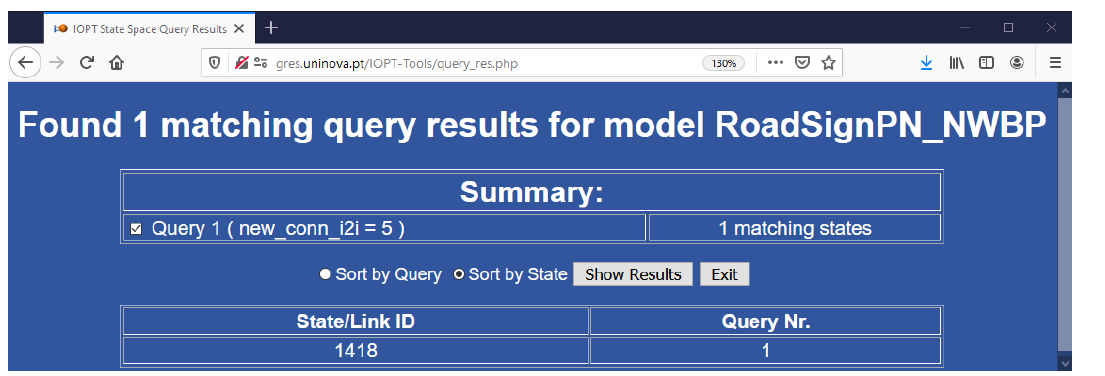
Figure 9. Query results of the controller model of the NWBP